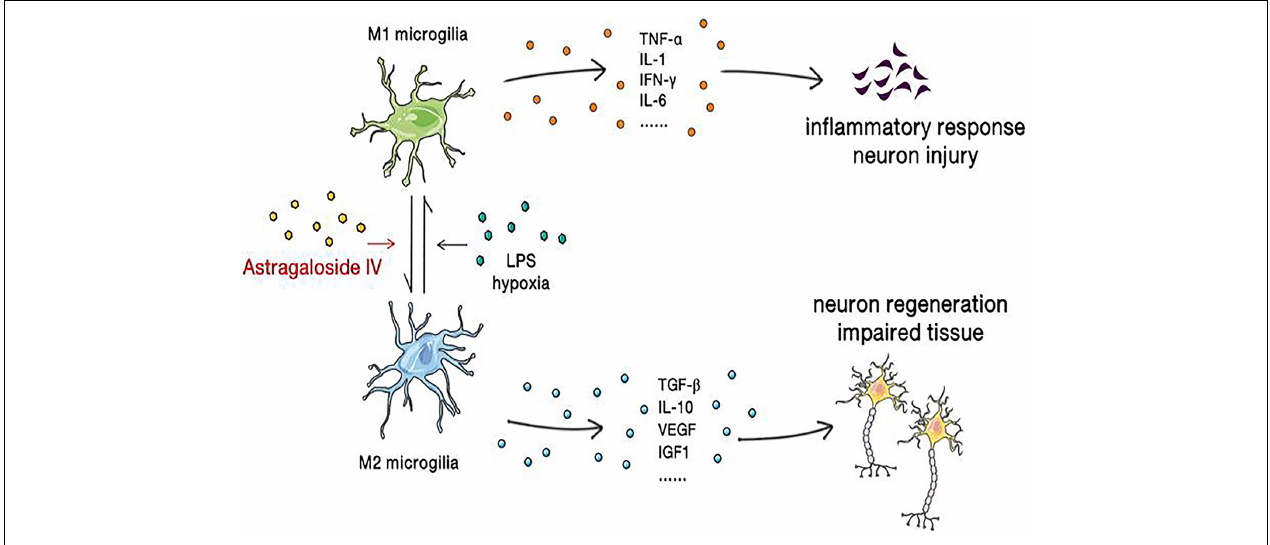
FIGURE 4 | Astragaloside IV reverses microglial polarization, reduces the inflammatory response, ameliorates neuronal injury, and promotes the regeneration of neurons and the repair of brain tissue.